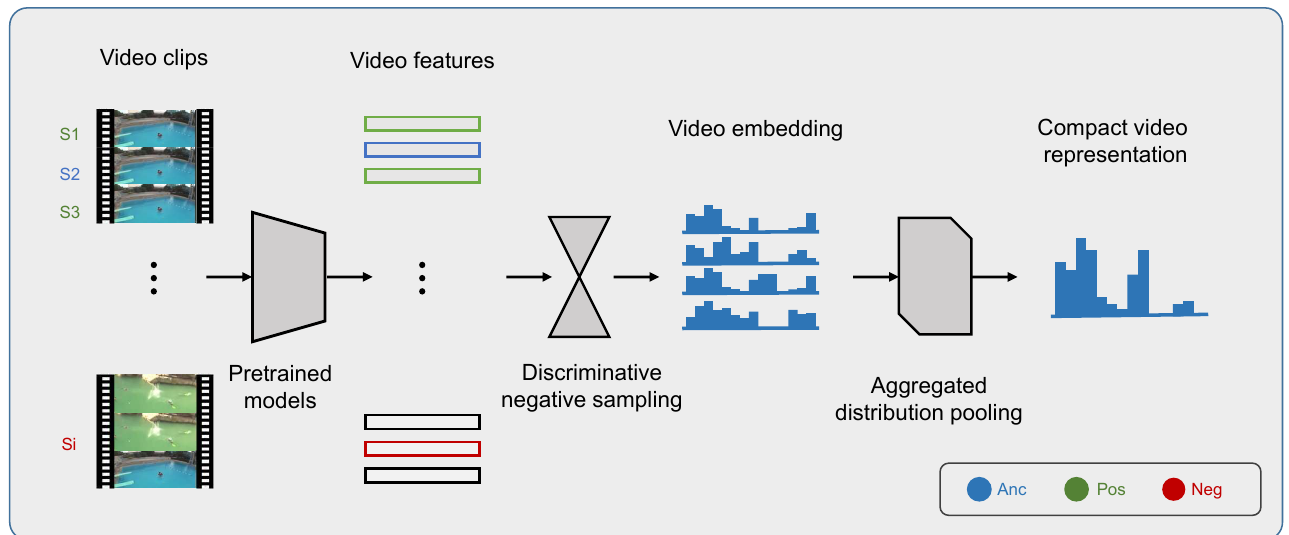
Figure 2. The proposed Video2Word framework for compact video representation. Given a set of raw videos, we first extracted features of video clips by pre-trained models. Inspired by continuous bag-of-words (CBOW) model, we then conducted a continuous video semantic embedding model to learn the distribution of video words. Integrated with a novel discriminative negative sampling approach, the obtained video embedding encodes both the long-term semantic and the discriminative information of video clips. Finally, we proposed an aggregated distribution pooling approach that captures the distribution of kernel mode of video semantics to obtain the compact video representations.